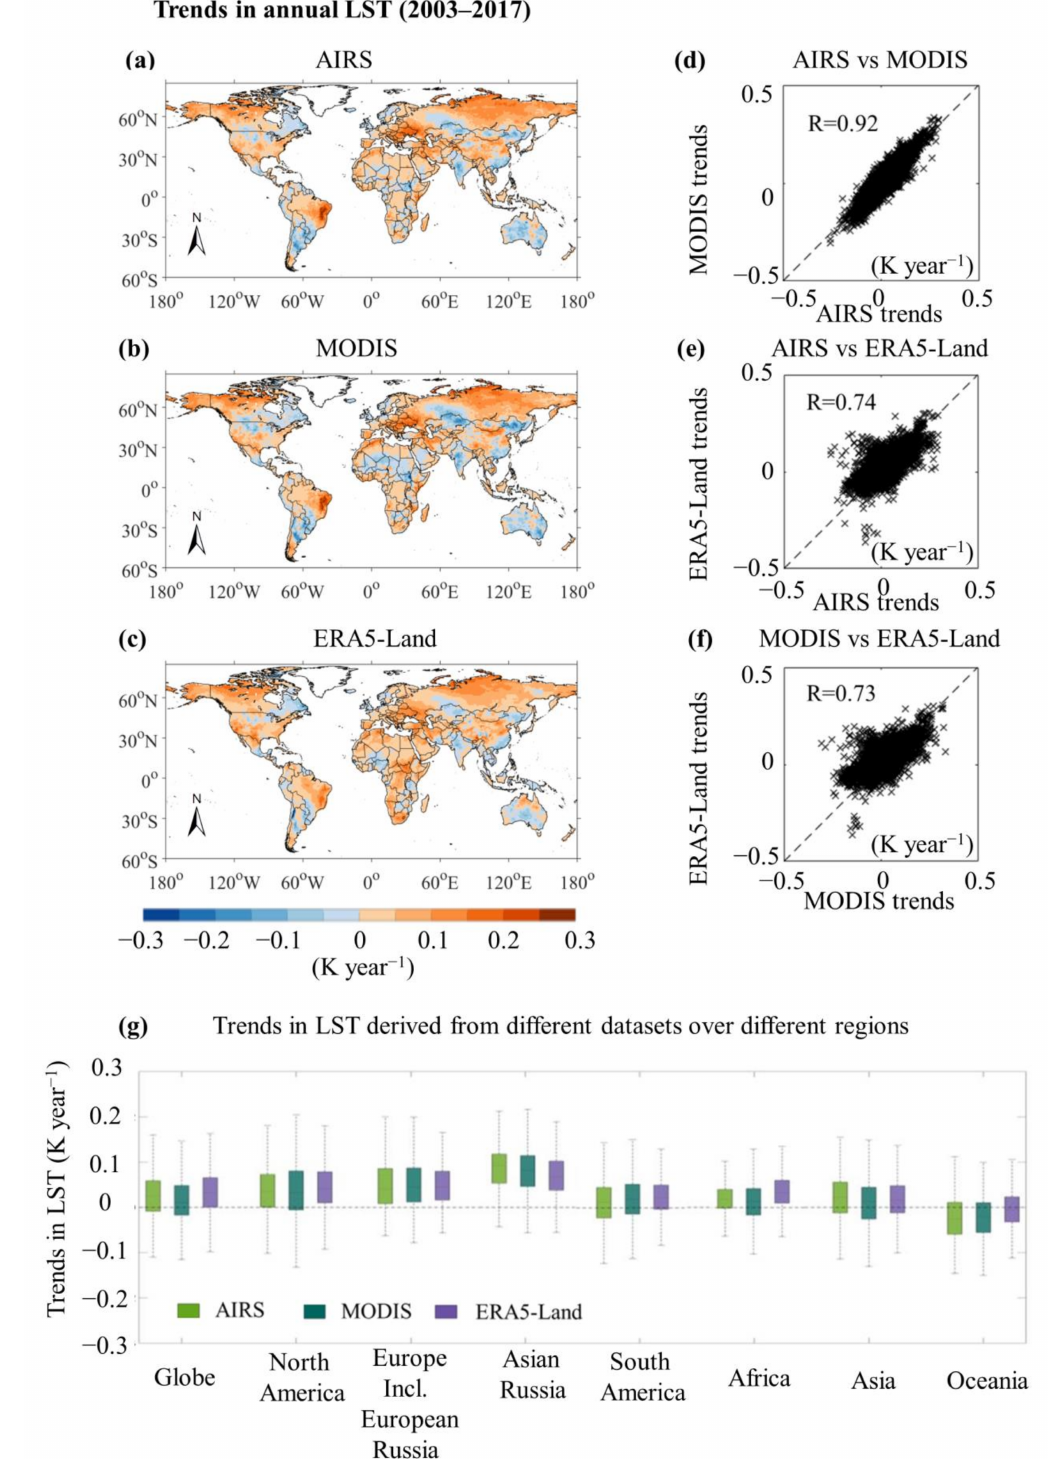
Figure 1. ( a – c ) Spatial patterns of trends of annual LST during 2003–2017 over each 1 ◦ grid cell derived from AIRS, MODIS, and ERA5-Land, respectively. ( d – f ) Scatter plots of trends in LST over each 1 ◦ grid cell derived from AIRS, MODIS, and ERA5-Land, as shown in ( a – c ). ( g ) Boxplots of trends in LST stratified by regions. The bottom, middle, and top bands of the box represent the 25th, 50th (median), and 75th percentiles, respectively. The ends of the whiskers represent the 5th and 95th